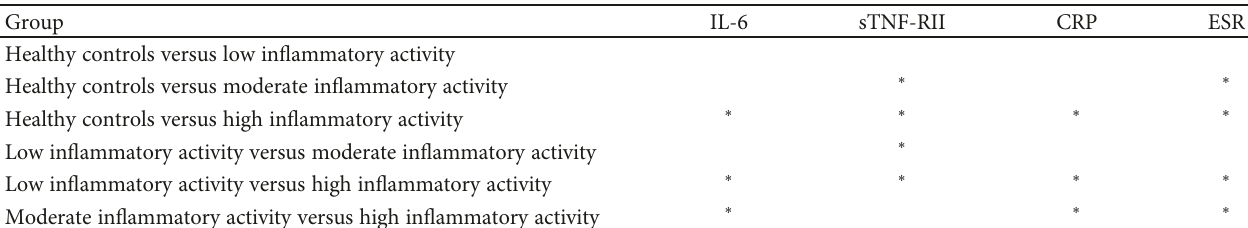
Table 4: Bonferroni ’ s post hoc test for pairwise comparisons among the four groups based on their HS-PGA scores. Group IL-6 sTNF-RII CRP ESR ∗ ∗ ∗ ∗